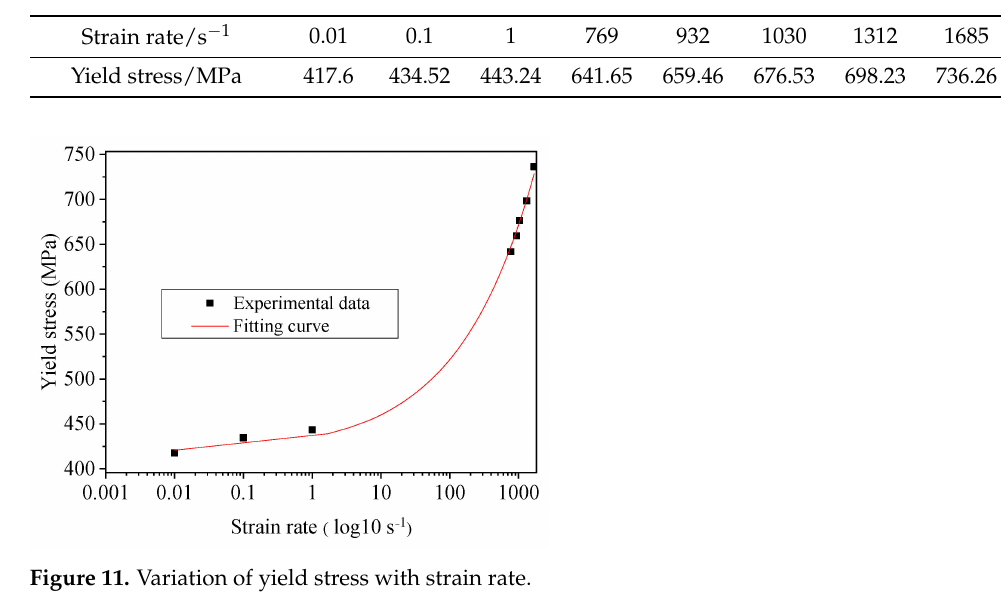
Table 1. Dynamic mechanical properties of EH36 steel at room temperature.